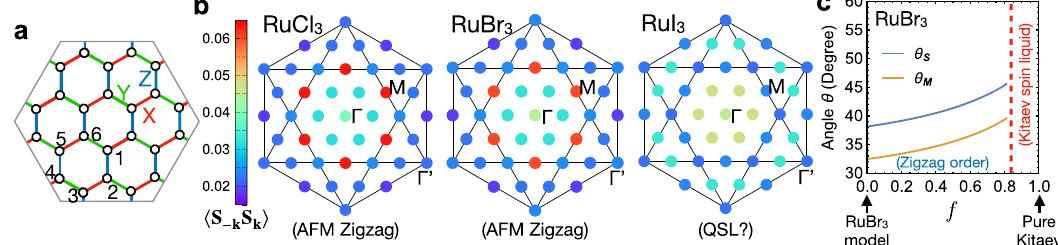
Fig. 6 Exact diagonalization of RuX 3 pseudospin models. a Employed periodic cluster. Labeled sites 1, … , 6 de fi ne the Kitaev plaquette operator W pseudospin (magnetic moment) within the zigzag phase when tuning from the RuBr 3 model ( f = 0) towards the pure Kitaev model ( f = 1). Dashed vertical line indicates phase transition to the Kitaev spin liquid, identi fi ed by a peak in − ∂ 2 E / ∂ f 2